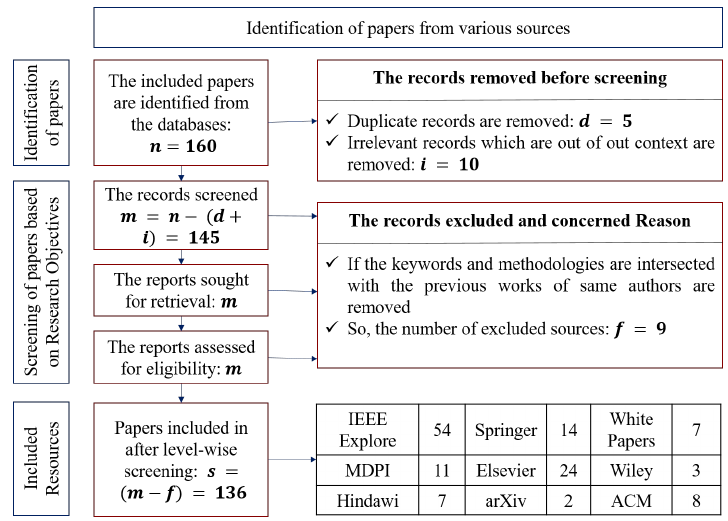
Figure 1. Flow diagram of our systematic investigation using the PRISMA approach.